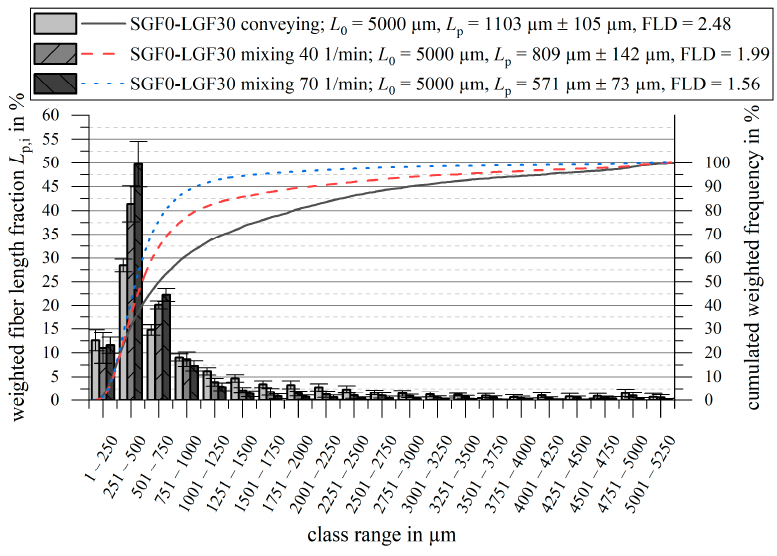
Figure 14. Fiber length measurement results for PF-SGF0-LGF30 (usage and extension of the results presented in [57,58]).